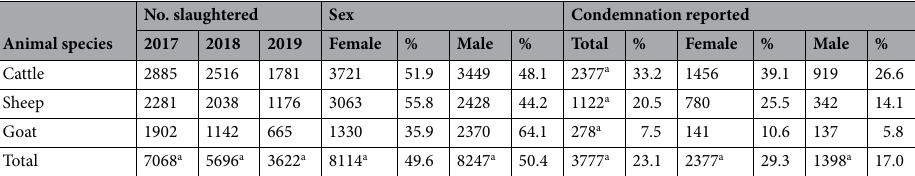
sourcing animals from the local area.